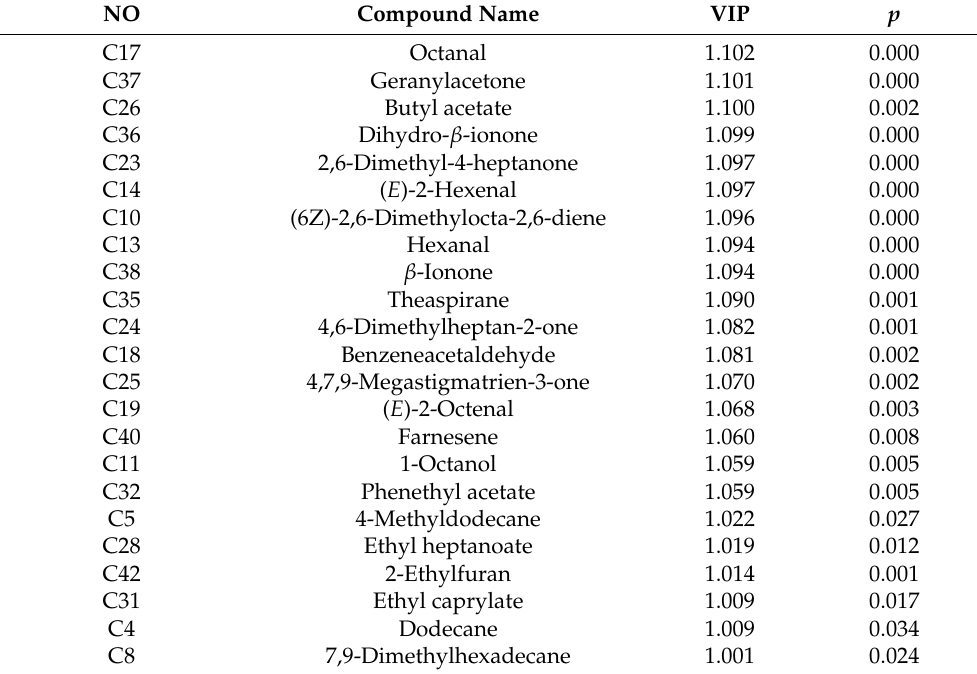
Table 2. Key volatile compounds based on VIP > 1 and p < 0.05.